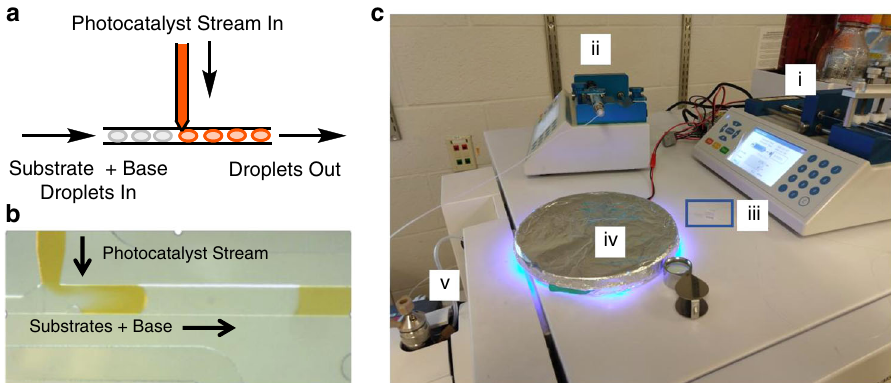
Fig. 4 Incorporation of a micro fl uidic chip for reagent addition. a Reagent addition device design. b Device in operation. Each incoming droplet from the left received a solution from the upper channel and moved right to export. c Full setup for in-droplet fl ow reaction screening. (i) Syringe pump driving both droplet fl ow and reagent fl ow into reagent addition chip, (ii) Syringe pump driving sheath fl ow, (iii, in blue box) Reagent addition device, (iv) Photoreactor chamber, (v) Sheath sprayer for